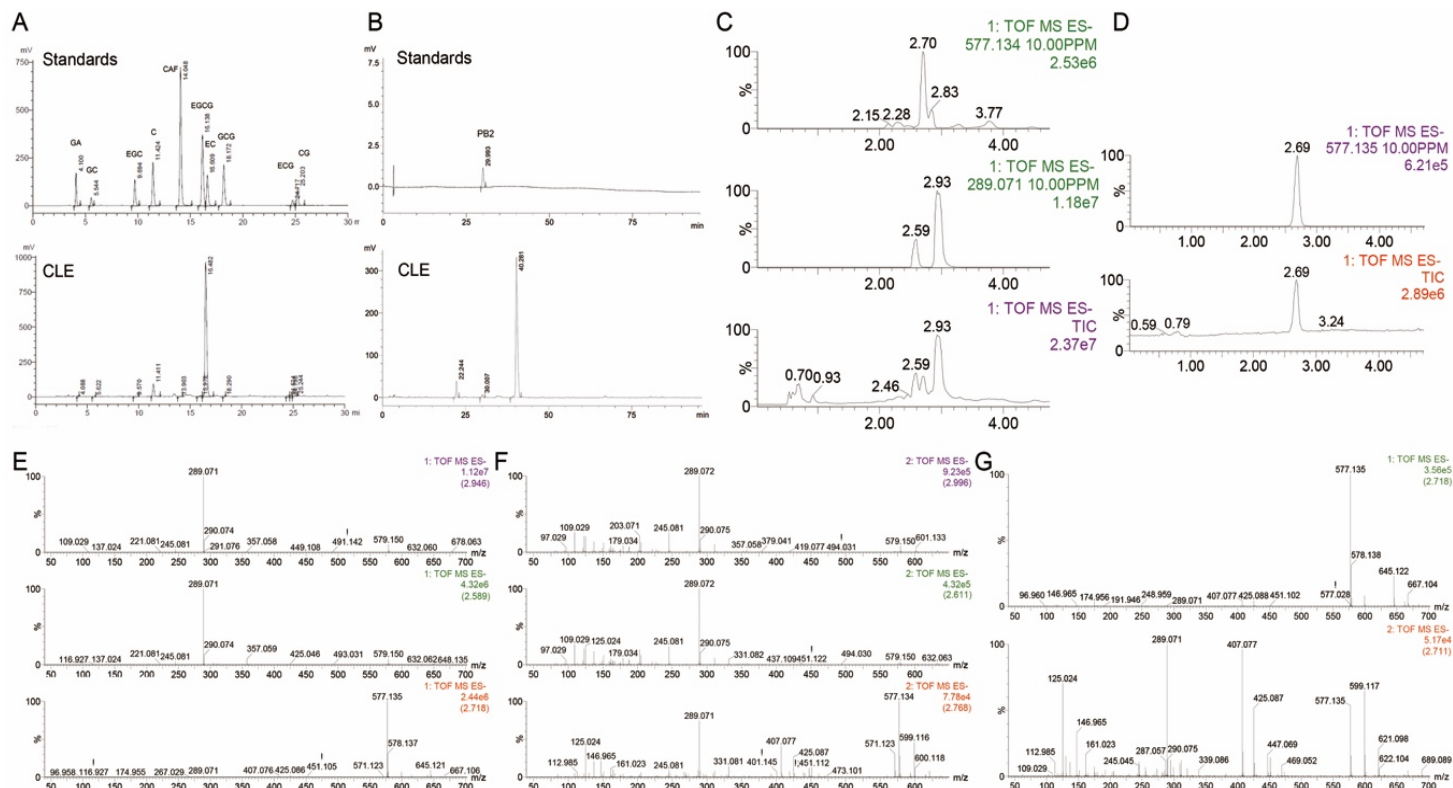
Figure 2. HPLC-UV and ultra-performance liquid chromatography-quadrupole-time-of-flight/mass spectrometry (UPLC-Q-TOF/MS) analysis of the Castanopsis lamontii water extract (CLE). ( A ) HPLC chromatograms of gallic acid, caffeine and catechins; ( B ) HPLC chromatograms of procyanidin B2 (PB2); ( C ) Total ion chromatogram of CLE ( lower ), ion chromatogram of CLE at m / z 289.071 ( middle ) and ion chromatogram of CLE at m / z 577.134 ( upper ) at ESI − ; ( D ) Total ion chromatogram of the PB2 standard ( lower ) and ion chromatogram of the PB2 standard at m / z 577.134 ( upper ); ( E ) ESI − -MS spectra of peaks at retention time 2.718 min for PB2 ( lower ), 2.589 min for C ( middle ), and 2.946 min for EC ( upper ), respectively; ( F ) ESI − -MS/MS spectra of peaks at retention time 2.768 min for PB2 ( lower ), 2.611 min for C ( middle ), and 2.996 min for EC ( upper ), respectively; ( G ) ESI − -MS/MS spectra of the peak at retention time 2.718 min for the PB2 standard ( lower ) and ESI − -MS spectra of the peak at retention time 2.711 min for the PB2 standard ( upper ).